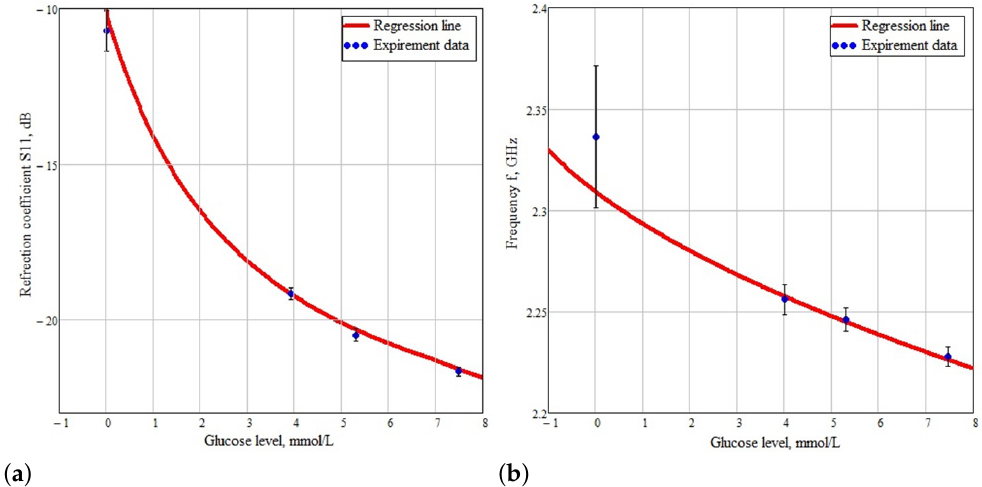
Figure 15. Dependence of the reflected signal on the glucose concentration at a frequency of 2.235 GHz ( a ) and the dependence of the frequency on the glucose concentration ( b ) in